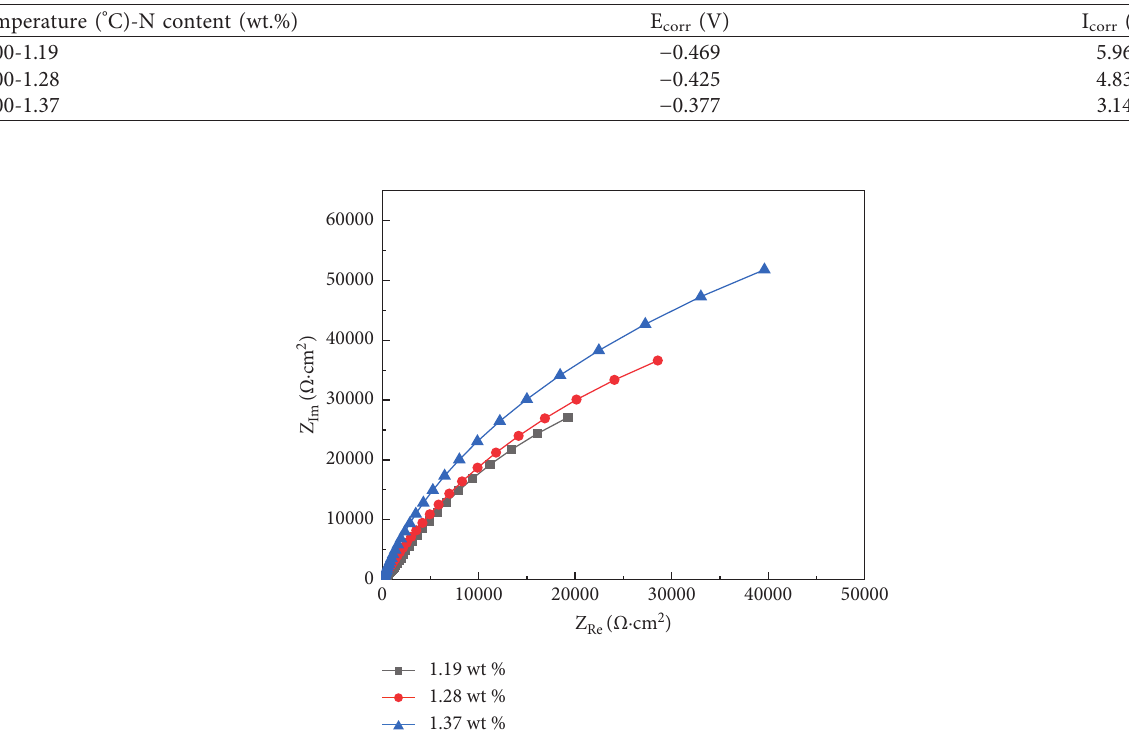
Figure 7: Nyquist diagram of the HNNS samples with different N contents in a 3.5% NaCl solution.